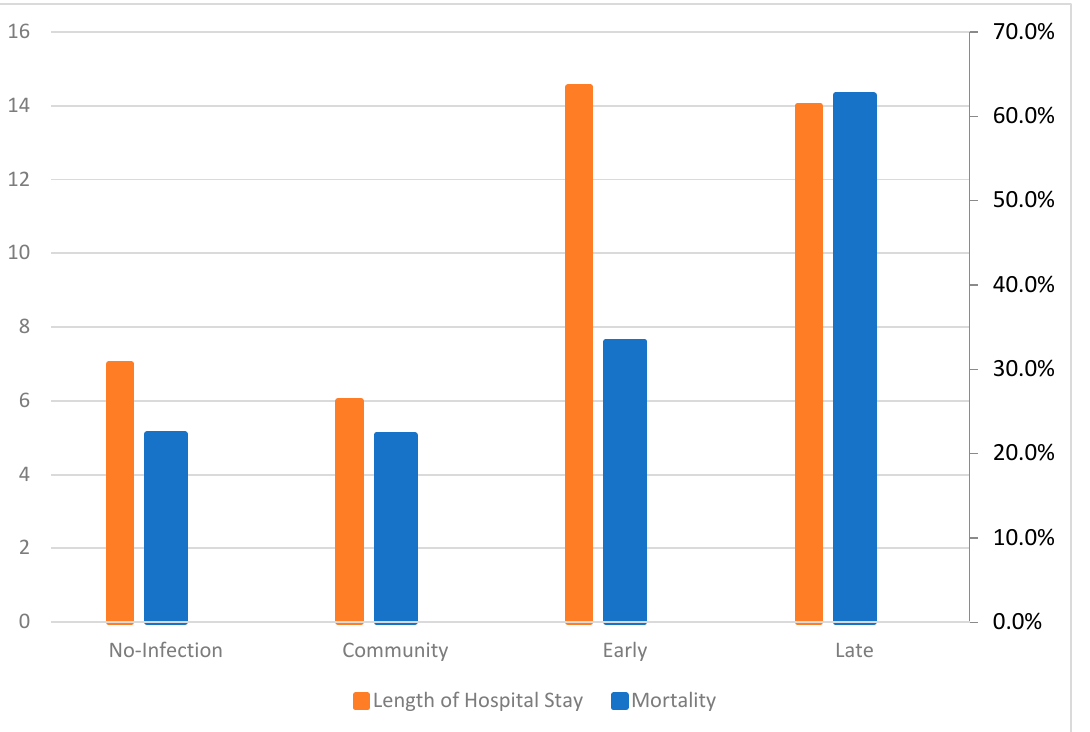
Figure 1. Differences in Length of Hospital Stay and Mortality between groups.